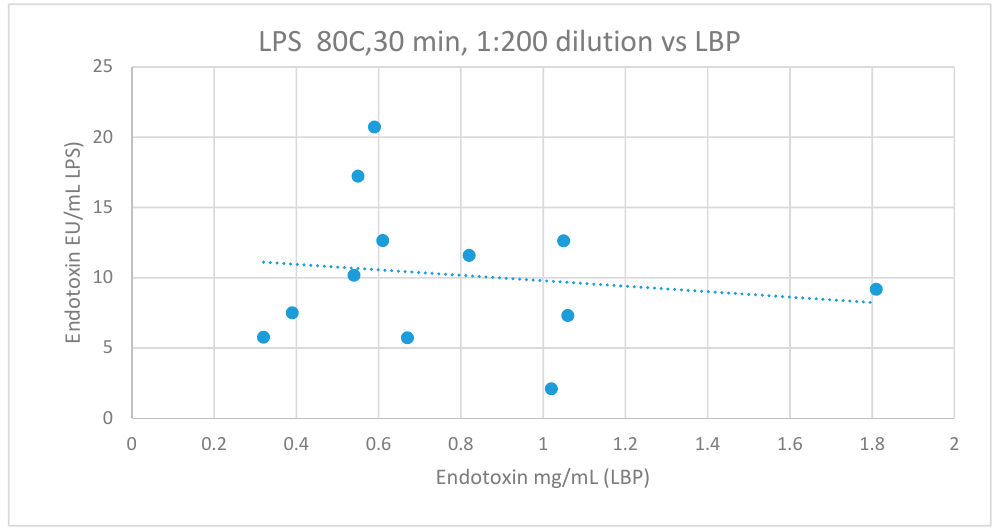
Figure 3. The relationship between LPS (with sample pre-treatment of 80 °C, 30 mins, 1:200 dilution) and LBP. Lipopolysaccharide (LPS), Lipopolysaccharide binding protein (LBP), r = − 0.278, p = 0.381, CI 95 ( − 0.916–0.381).